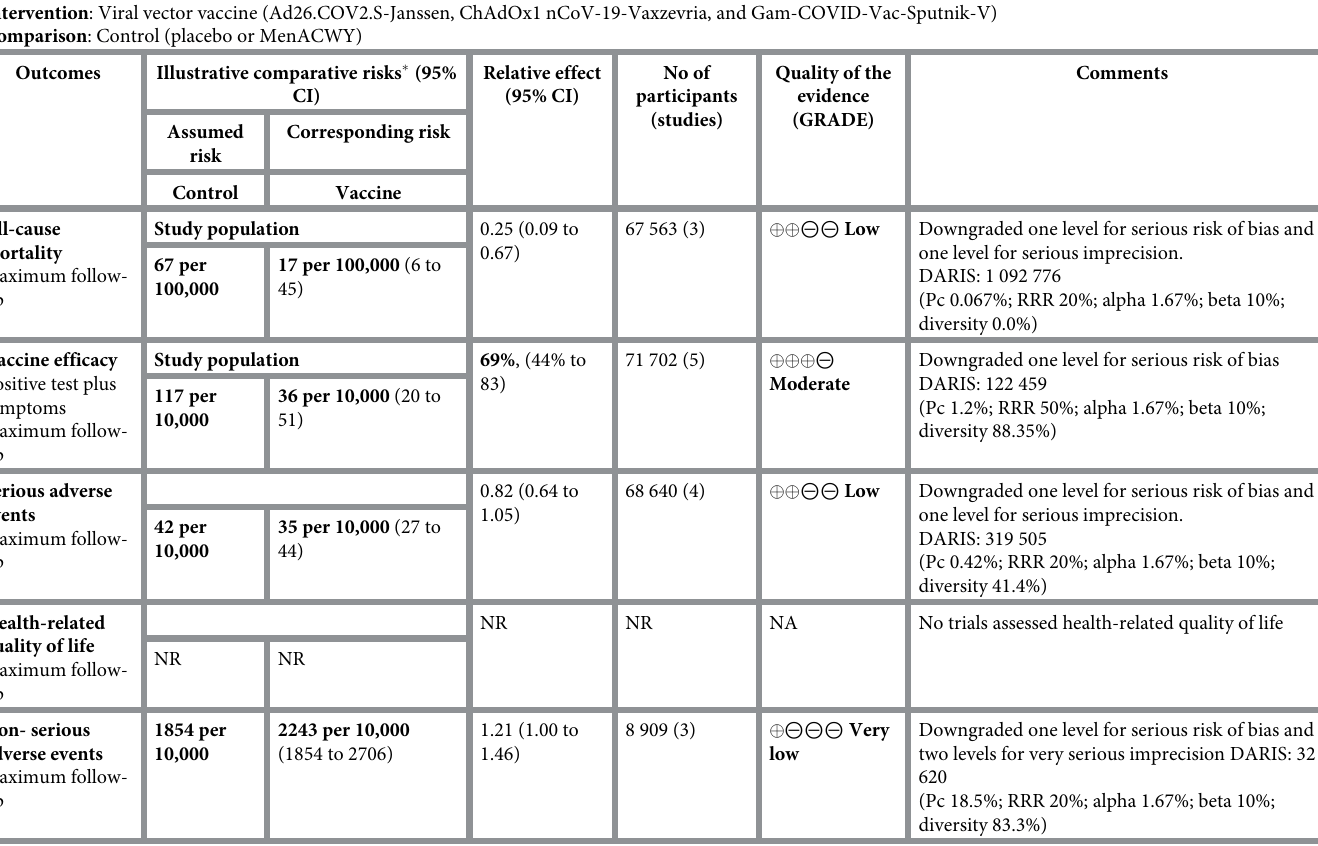
Table 4. Summary of findings (viral vector vaccines). Viral vector vaccines versus control Population : General population Settings :